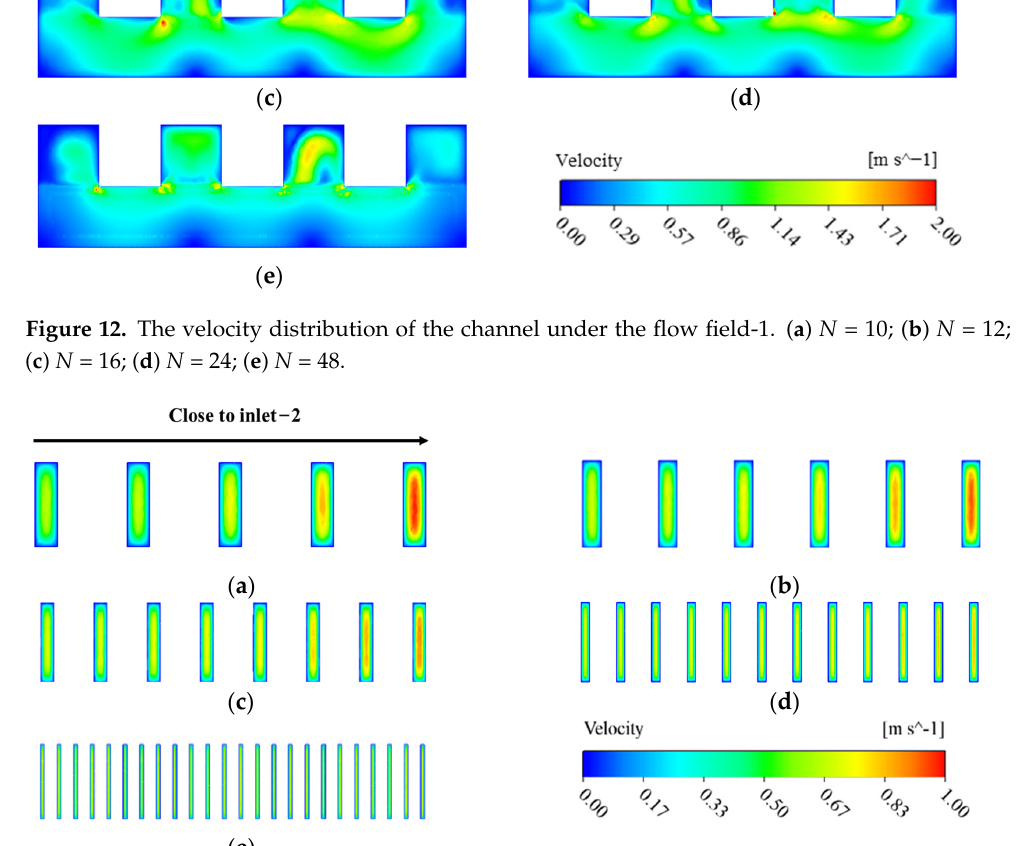
Figure 12. The velocity distribution of the channel under the flow field-1. ( a ) N = 10; ( b ) N = 12; ( c ) N = 16; ( d ) N = 24; ( e ) N = 48.